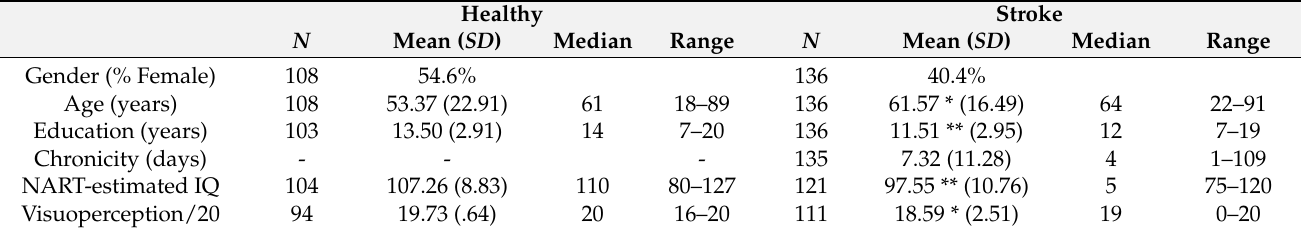
Table 1. Demographics for Participants (Healthy and Stroke